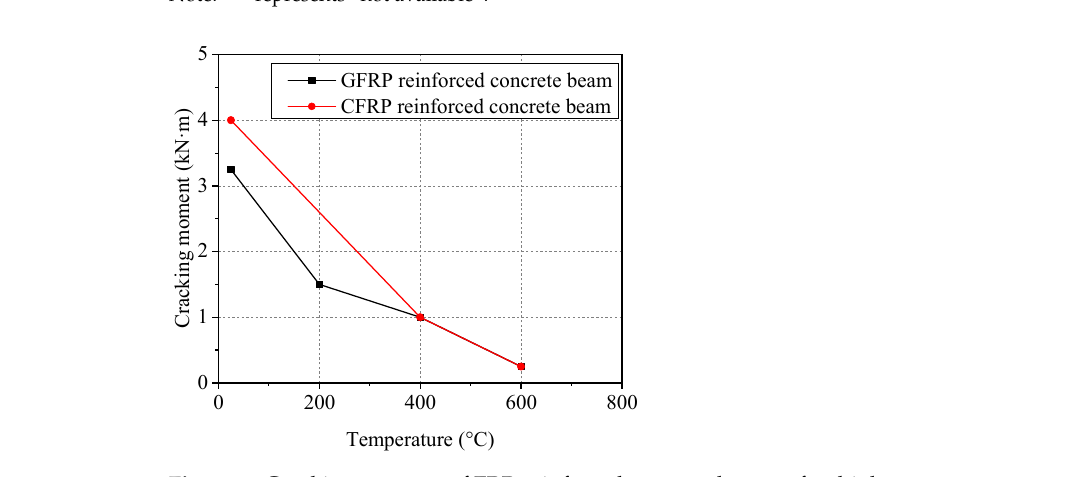
Figure 6. Cracking moment of FRP-reinforced concrete beams after high-temperature exposure.